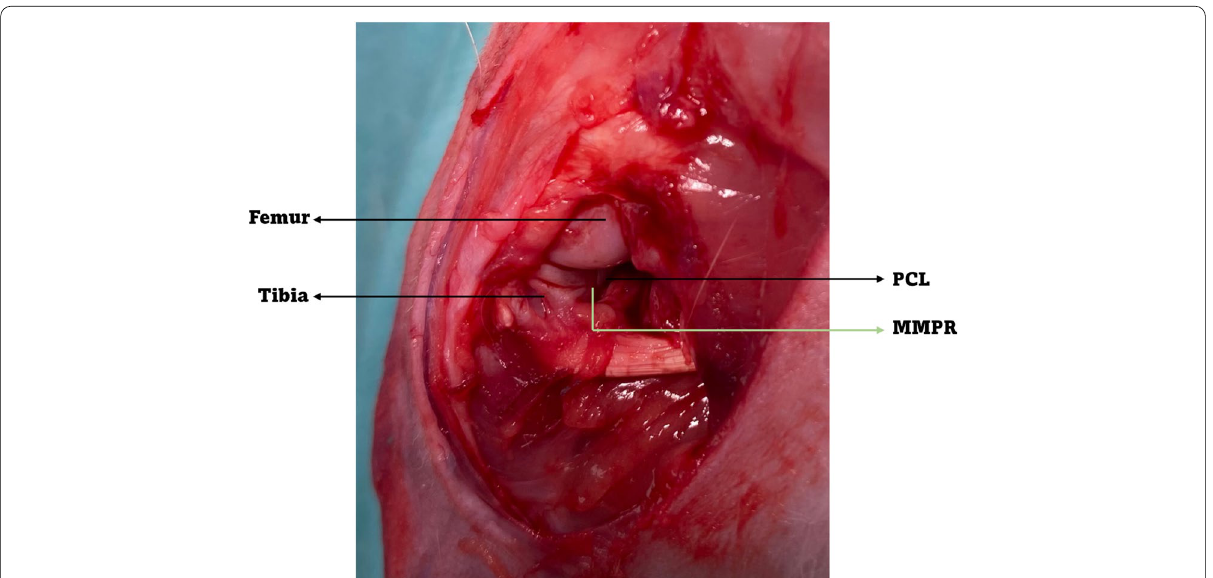
Fig. 1 Meniscectomy was performed by transecting the medial meniscus posterior root with a radial cut (PCL, posterior cruciate ligament; MMPR, medial meniscus posterior